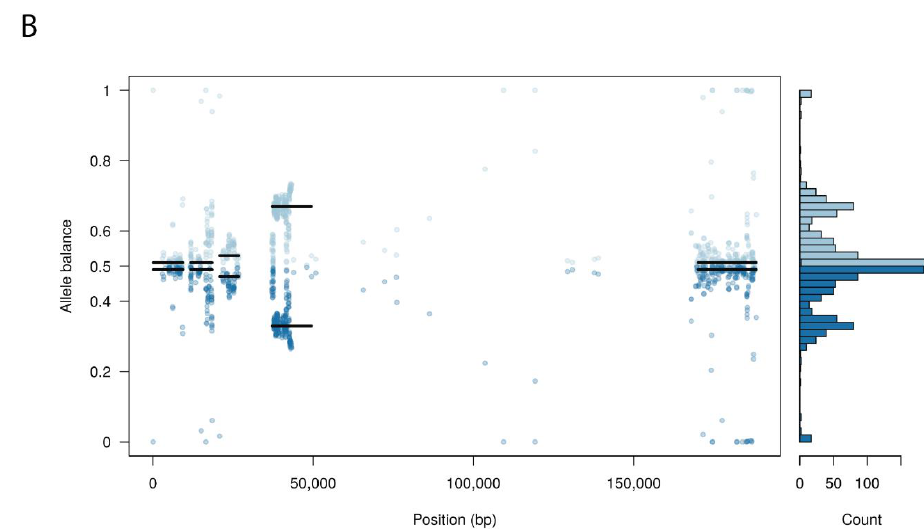
Figure 3. Genome assembly of Arm/07/CBM/c4. ( A ) Whole genome coverage plot using Illumina and Nanopore (ONT) sequencing reads mapped to the ASFV Arm / 07 isolate clone 4 assembly. ( B ) Allele Nanopore (ONT) sequencing reads mapped to the ASFV Arm/07 isolate clone 4 assembly. ( B ) Allele balance distribution of variants from Illumina reads along the Arm/07/CBM/c4 assembly. balance distribution of variants from Illumina reads along the Arm / 07 / CBM / c4